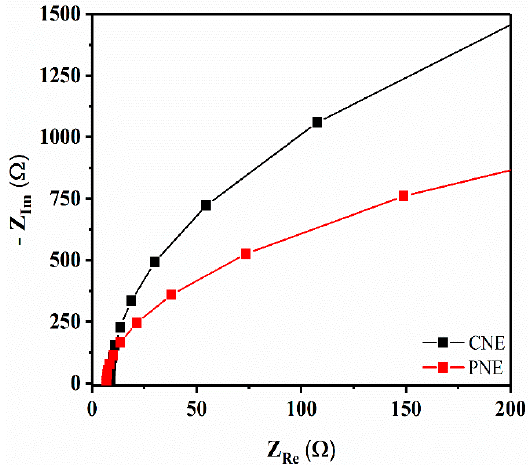
Figure 4. Fitted Nyquist plots from electrical impedance measurements of CNE and PNE (number of samples tested = one, N = 1; frequency 200 kHz–50 mHz and amplitude = 10 mV; measurements performed using saline electrolyte solution of 0.9 g NaCl in 100 mL deionized (DI) water). LFP was recorded from the cortices with CNE and PNE. Since LFPs are commonly measured